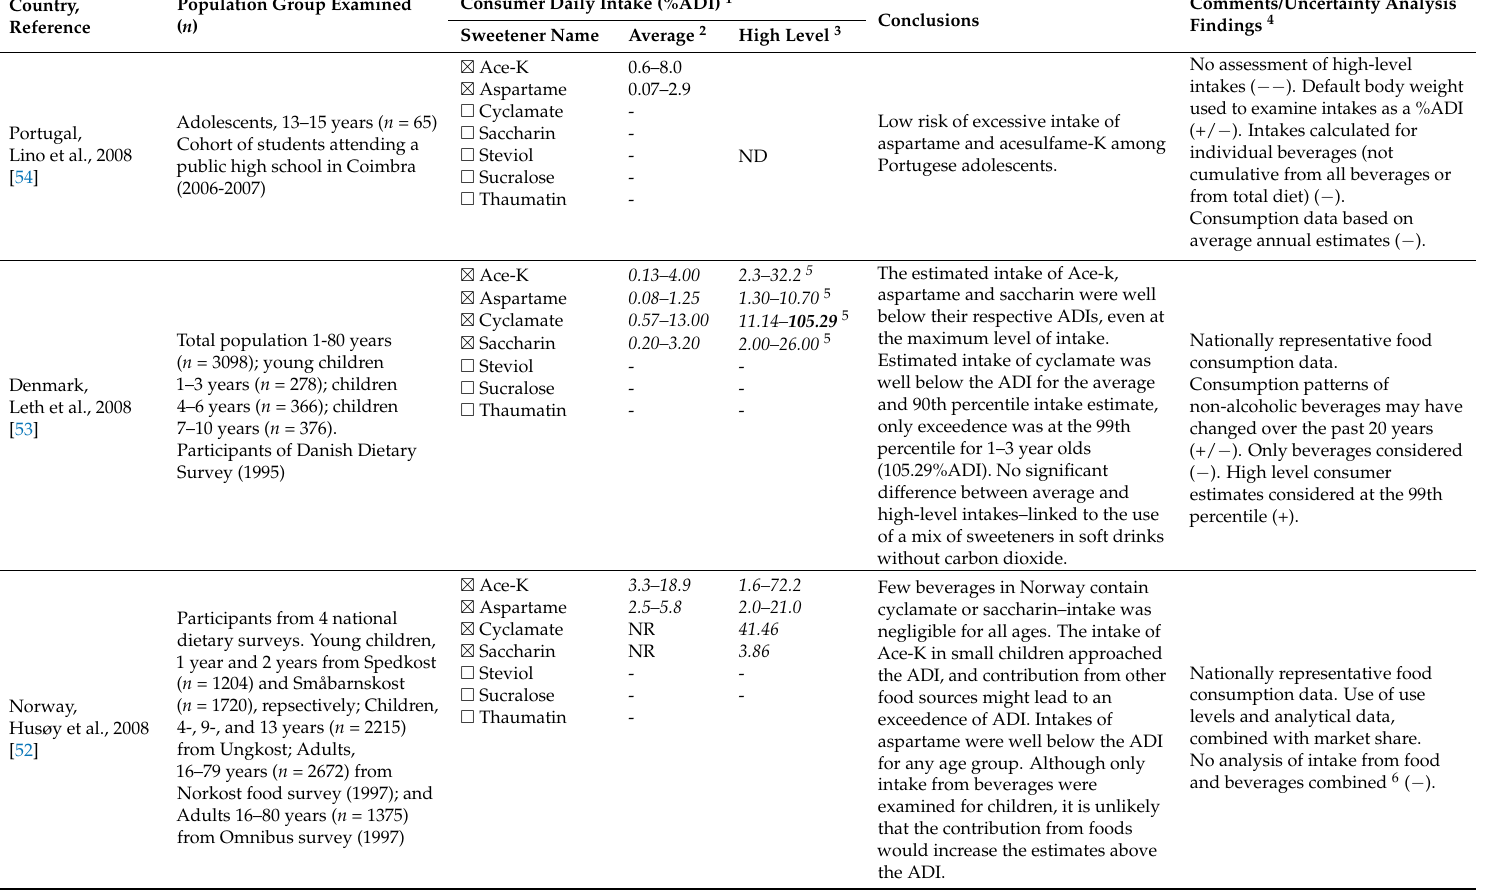
Table 3. Estimated Daily Intakes of Low-/No-Calorie Sweeteners in